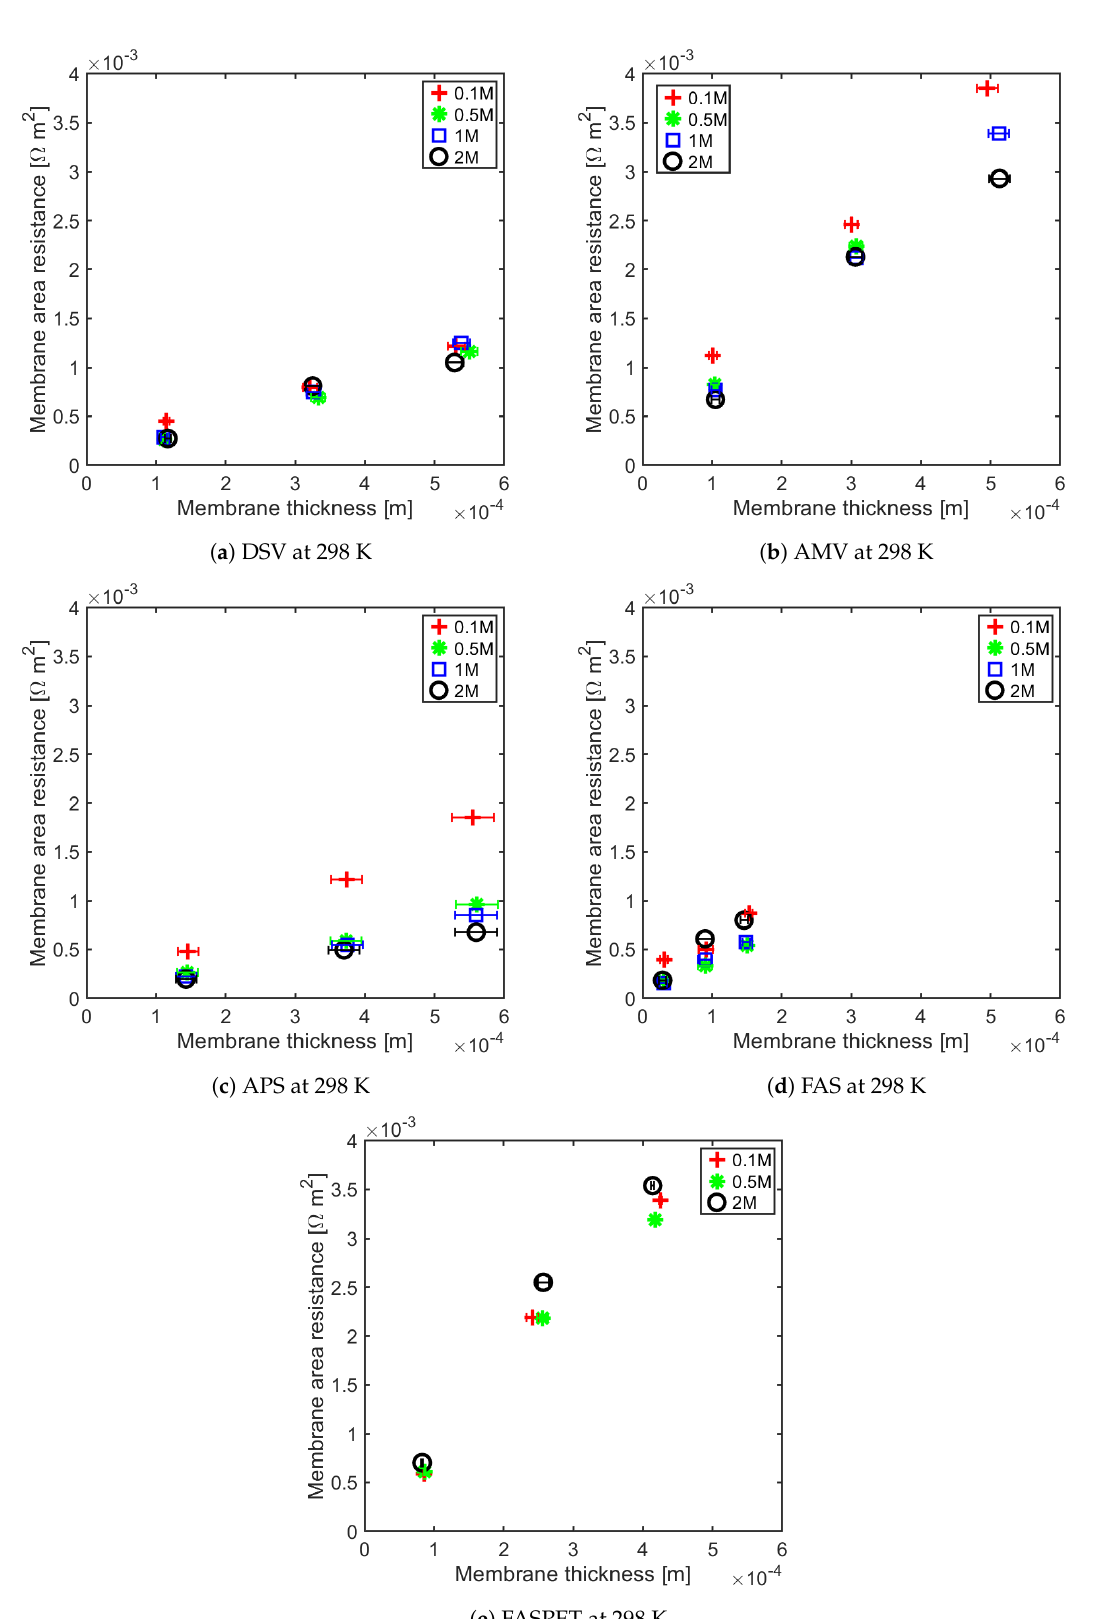
Figure 5. Anion exchange membrane (AEM) resistance as a function of thickness for different concentrations at 298